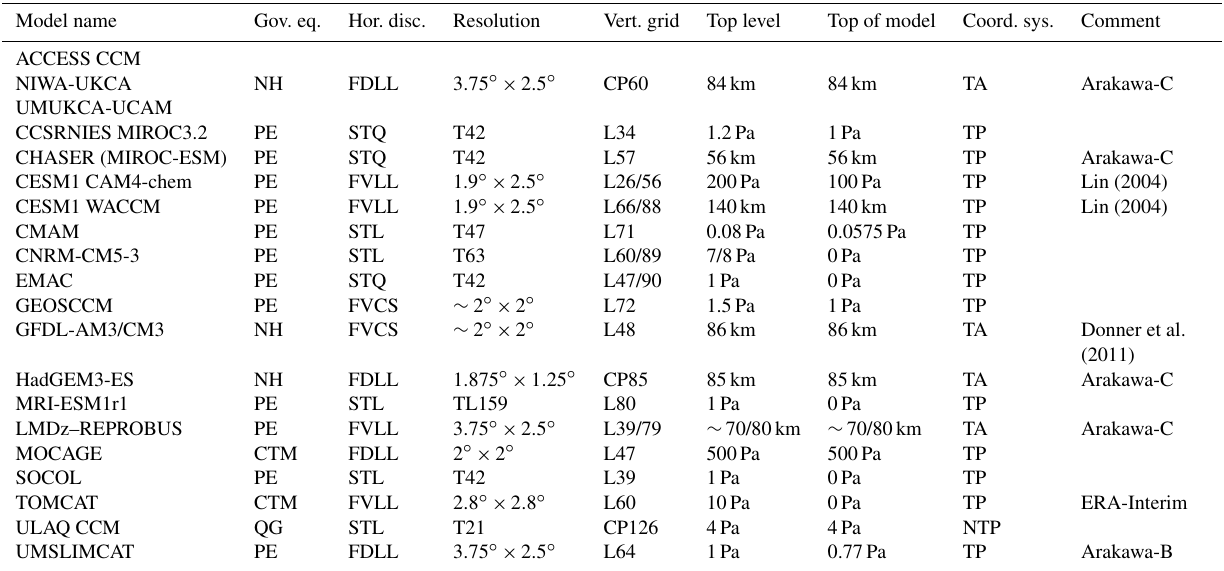
Table 3. Governing equations, horizontal discretization, and vertical grid of the atmosphere component of models. NH is non-hydrostatic; PE is primitive equations; QG is quasi-geostrophic; F[D,V]LL is finite [difference, volume] on lat–long grid; STQ is spectral transform quadratic; STL is spectral transform linear; CP is Charney–Phillips; TA is hybrid terrain-following altitude; TP is hybrid terrain-following pressure; NTP is non-terrain-following pressure; FVCS is finite volume cubed sphere; T21 ≈ 5 . 6 ◦ × 5 . 6 ◦ ; T42 ≈ 2 . 8 ◦ × 2 . 8 ◦ ; T47 ≈ 2 . 5 ◦ × 2 . 5 ◦